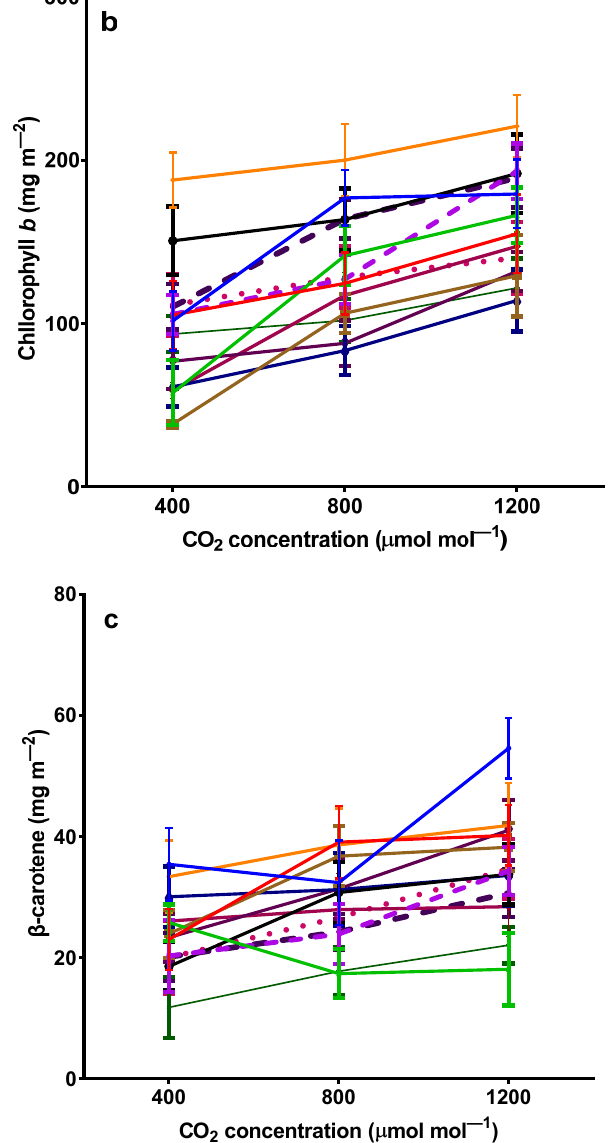
Figure 3. Chlorophyll a ( a ), Chlorophyll b ( b ) and β -carotene ( c ) concentrations from Brassicaceae plants grown at three carbon dioxide concentrations. The values are averages of three independent measurements.